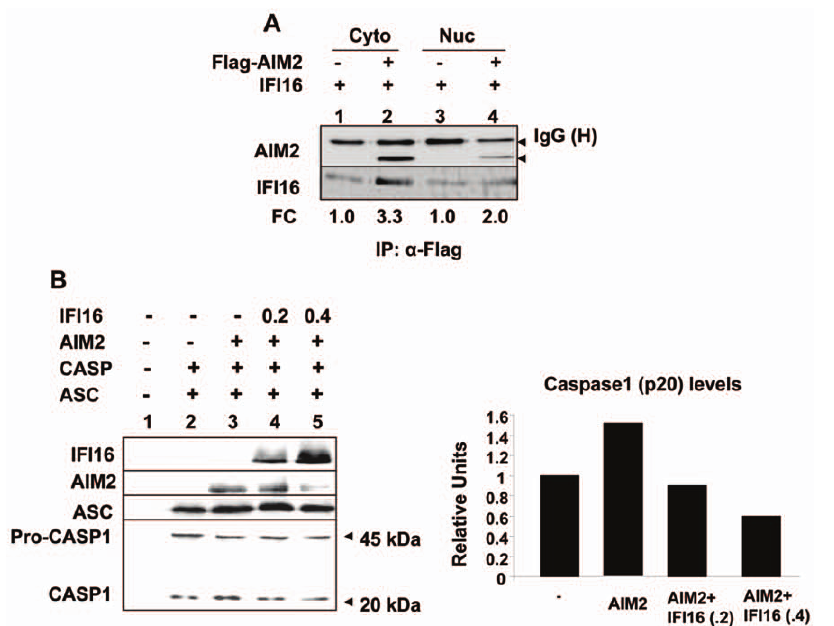
Figure 4. IFI16 protein binds to AIM2 protein in the cytoplasmic fraction and increased levels of the IFI16 protein inhibits the AIM2- ASC inflammasome-mediated activation of casapase-1. ( A ) Cultures of human embryonic kidney cells (HEK-293) at , 80% confluency were either transfected with pCMV-AIM2 plasmid (2 m g) allowing the expression of the FLAG-tagged human AIM2 protein or along with the pCMV-IFI16 plasmid (1 m g) allowing the expression of IFI16 protein. 40 h after the transfections, cells were fractionated into cytoplasmic and nuclear fractions and fractions containing approximately equal amounts of proteins were subjected to immunoprecipitation using specific antibodies to the FLAG-tag. The immunoprecipitates were analyzed by immunoblotting using antibodies to the FLAG-tag (the upper panel) or the IFI16 protein (the lower panel). The fold change (FC) in the IFI16 protein levels in immunoprecipitates is also indicated. ( B ) Left panel: HEK-293 cells were either left untransfected (lane 1) or transfected with plasmid DNAs encoding for the ASC (DNA 50 ng; lanes 2–5), CASP-1 (DNA 100 ng; lanes 2–5), AIM2 (200 ng; lanes 3–5), or IFI16 (200 or 400 ng; lanes 4 and 5 respectively) proteins. Total amount of plasmid DNA in the transfections was adjusted to 2 m g using the pCDNA3 plasmid DNA. About 40 h after the transfections, cell lysates were analyzed by immunoblotting using antibodies specific to the indicated proteins. Right panel: Relative caspase-1 (p20) protein levels shown in the left panel (lanes 1–4).